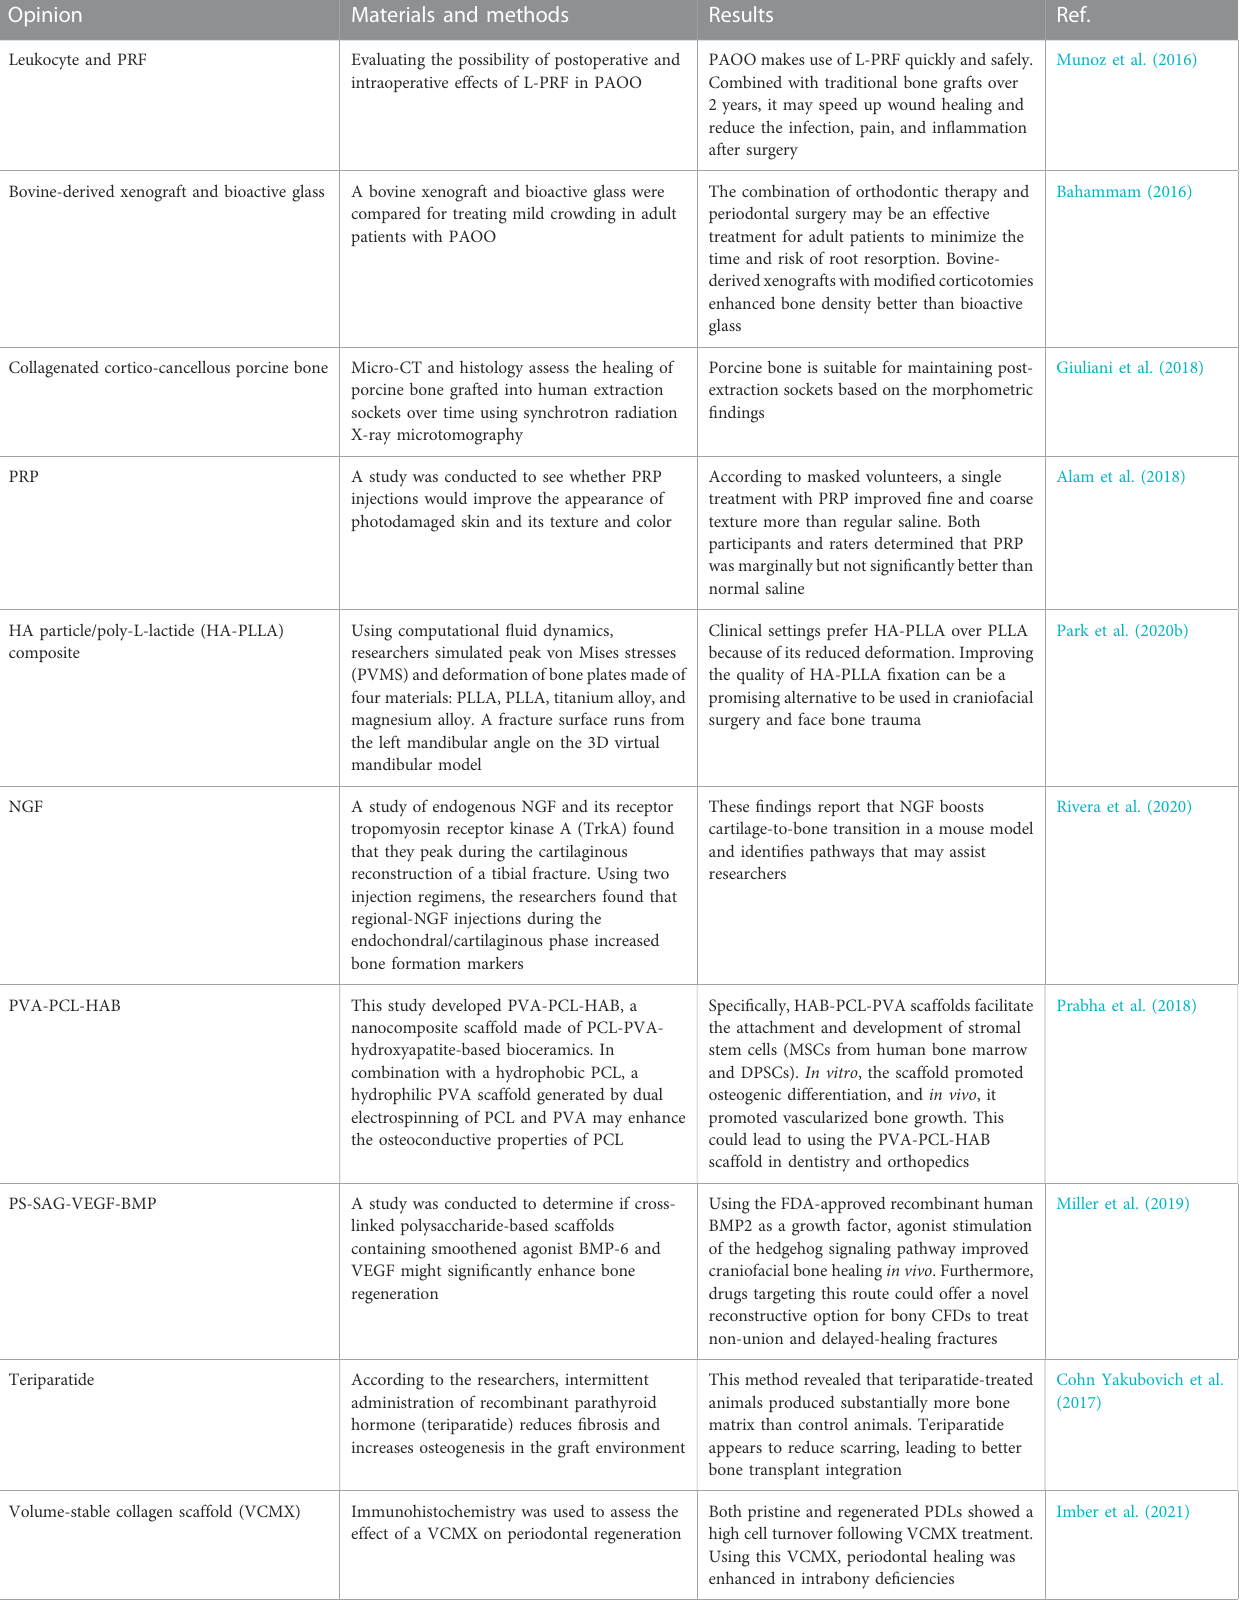
TABLE 3 Current biomaterial and synthetic material therapy in craniofacial